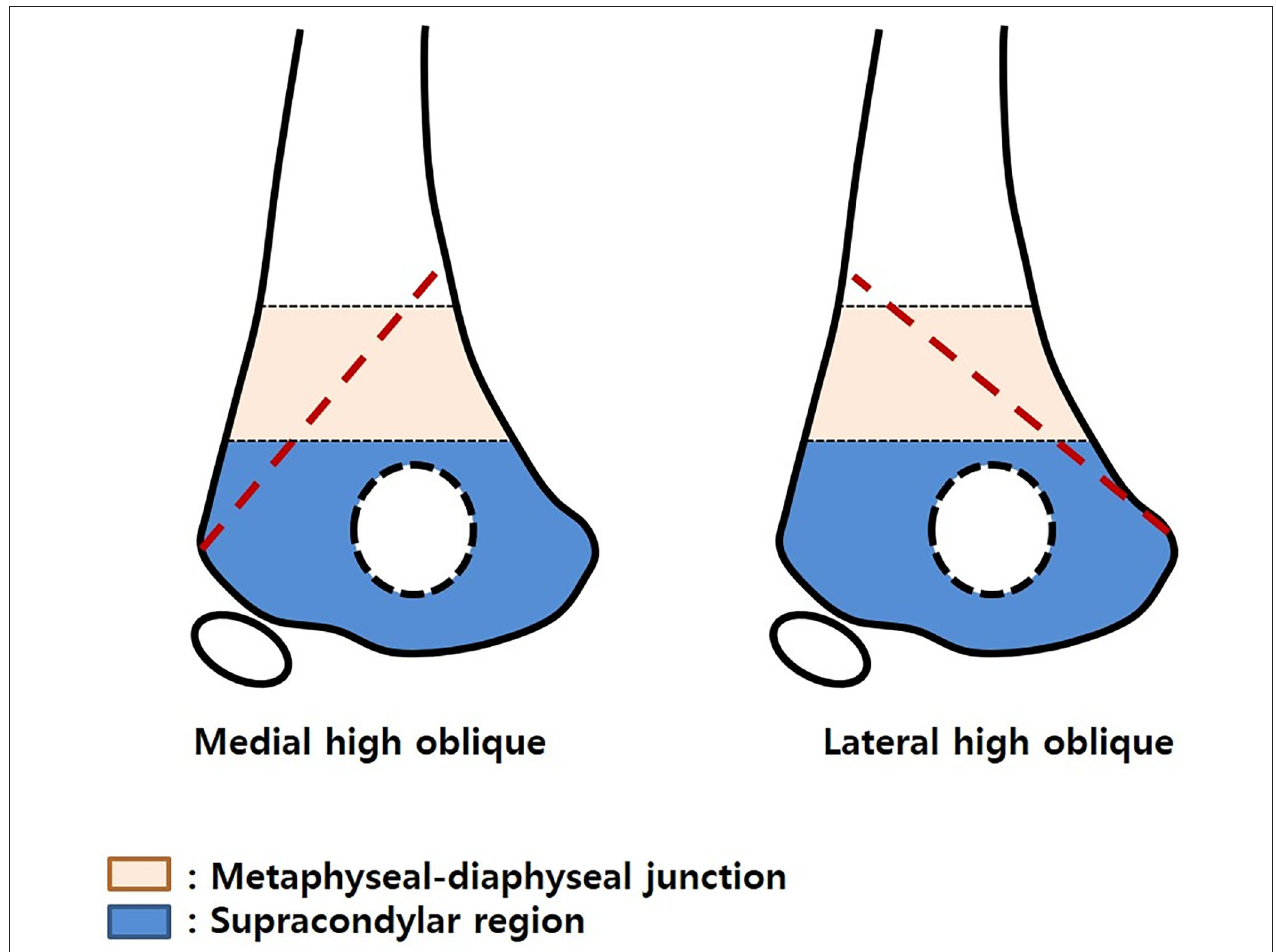
FIGURE 1 | Illustration of the high-long oblique supracondylar humeral